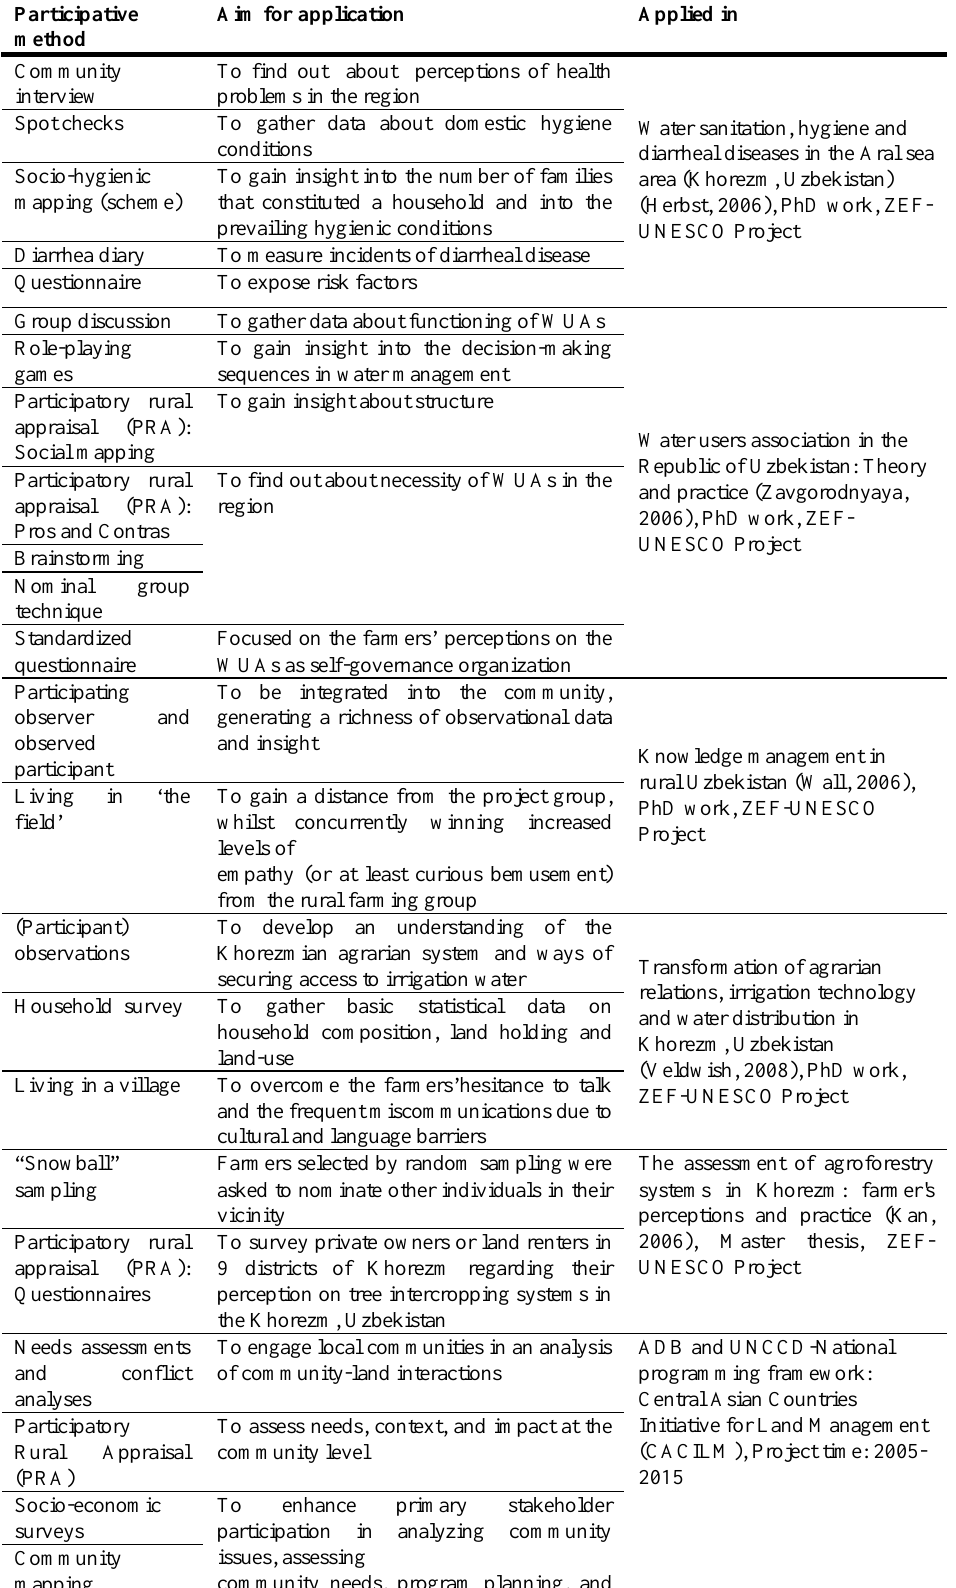
Table A.1 Overview of applied participative methods in